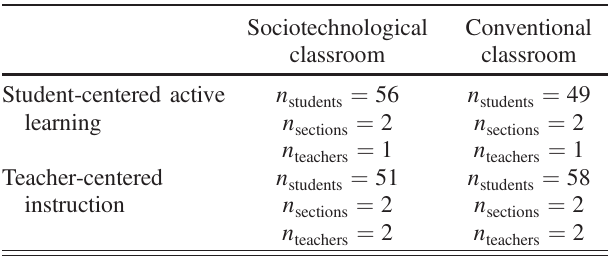
TABLE I. Number of students, sections, and teachers in the four conditions